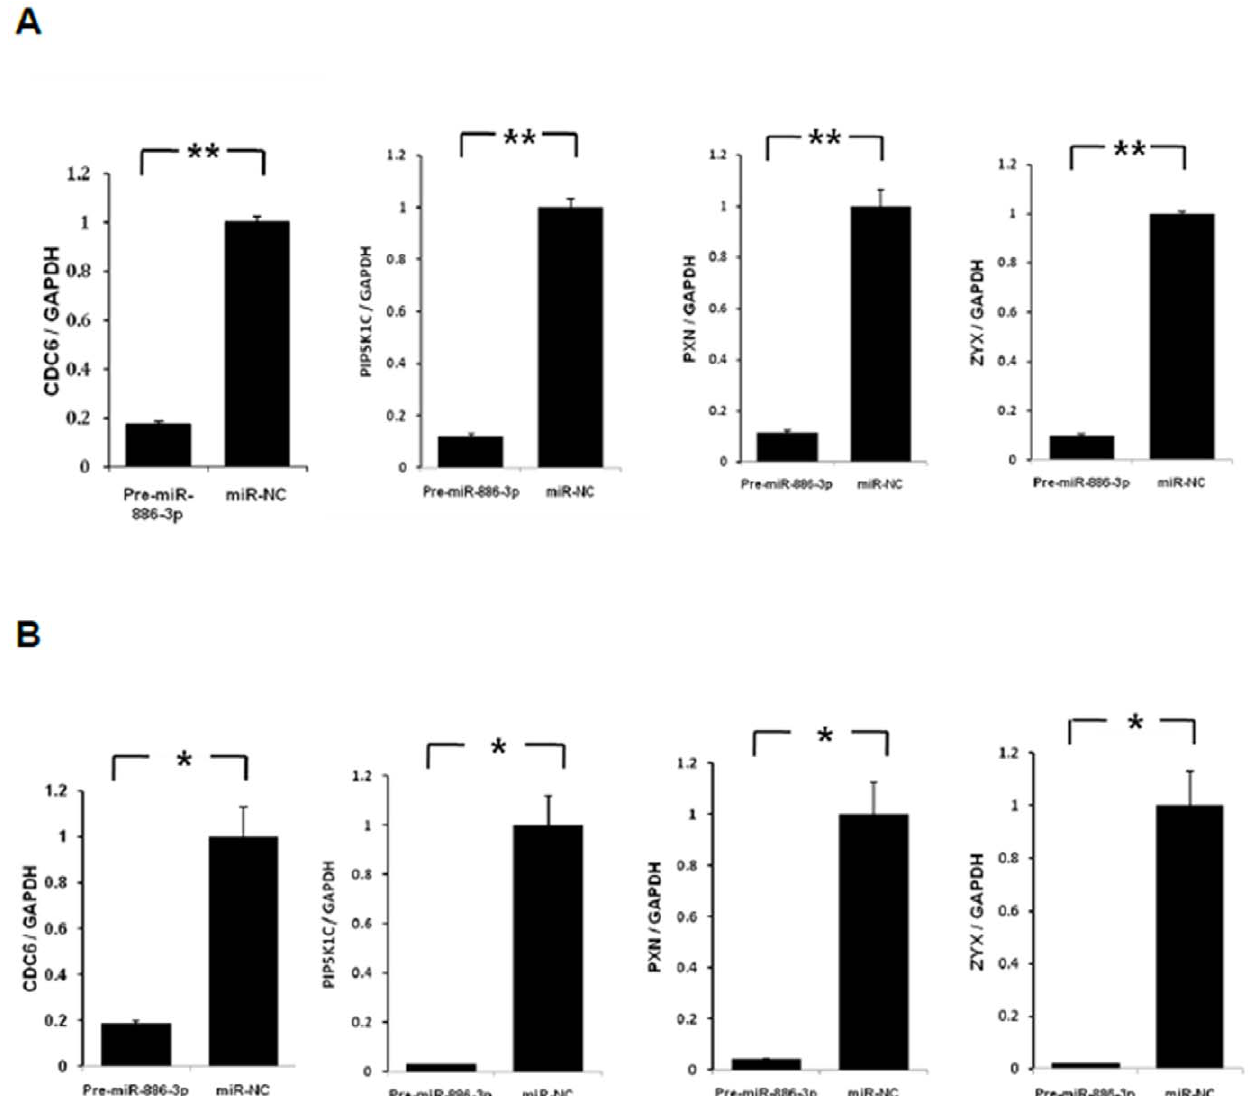
Figure 4. Validation of 4 target genes of miR-886-3p by quantitative RT-PCR. Transfection of pre-miR-886-3p significantly decreased the mRNA levels of four target genes ( CDC6 , PIP5K1C , PXN , ZYX ) in A ) TPC-1 cell line and B ) FTC-133 cell line (*p , 0.05; ** p , 0.01). The Y axis represents the ratio of the specific target gene and GAPDH using 2 - DD Ct method, and the value of the miR-NC group was set at 1.0 to allow comparison of fold differences among different cell lines and genes.